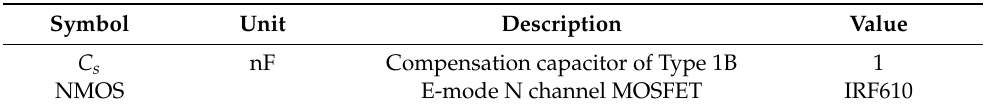
Figure 5. Type 1B — Modified cascode GaN HEMT power module. Table 2. Parameters of the Type 1B power module. Table 2. Parameters of the Type 1B power